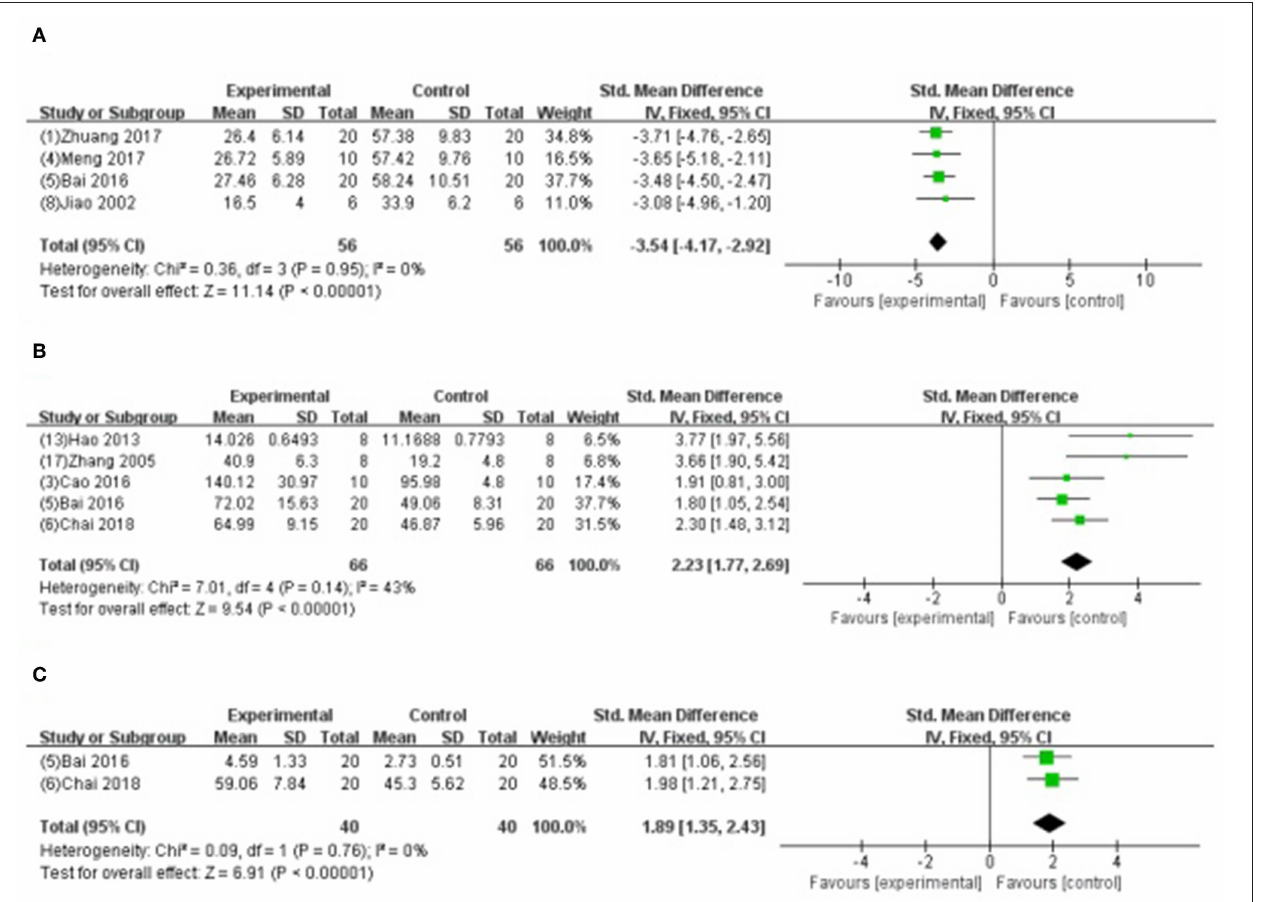
FIGURE 8 | (A) Forest plot of animal studies investigating the effect of GB onapoptosis index decrease. (B) Forest plot of animal studies investigating the effect of GB onsuperoxide dismutasedecrease. (C) Forest plot of animal studies investigating the effect of GB on glutathione